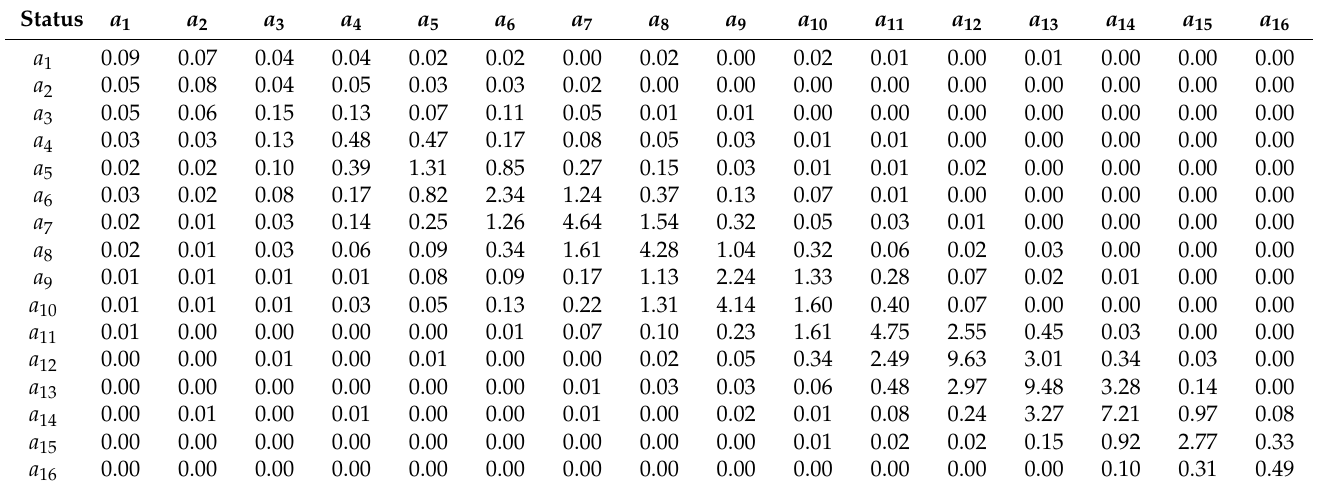
Table 6. One-step transition matrix for PM2.5. (The % is omitted after the